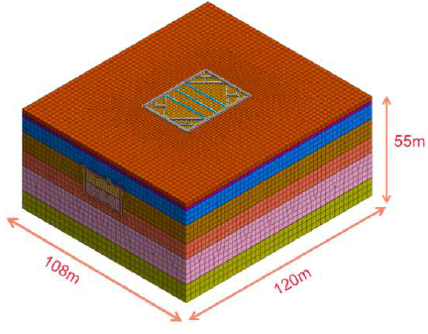
Figure 3. Finite element model.